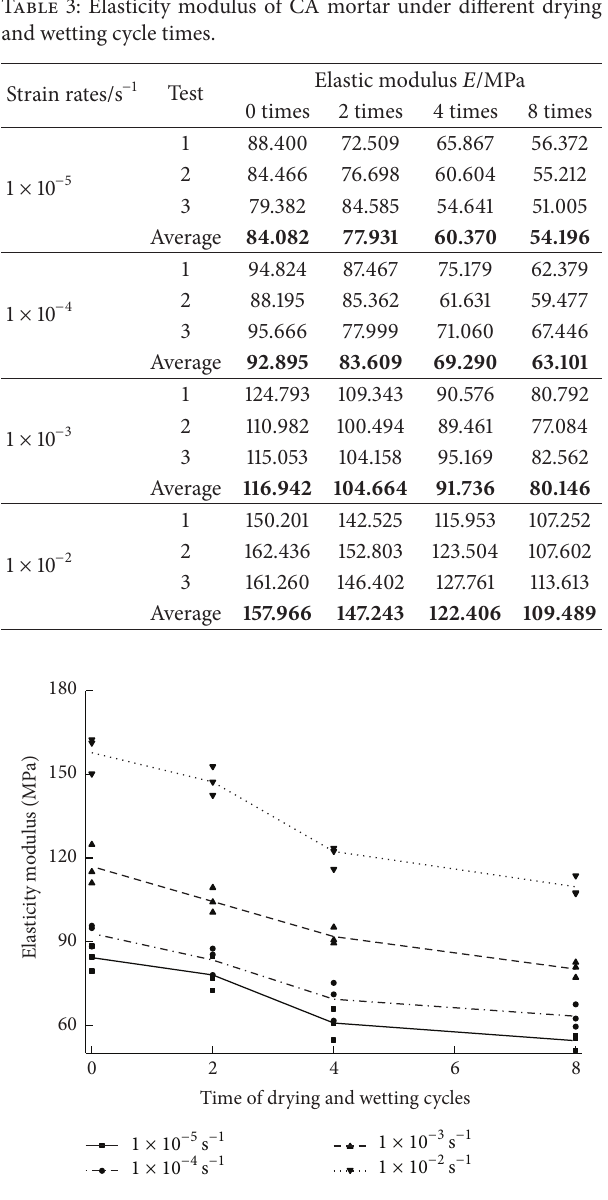
Figure 5: Elastic modulus of CA